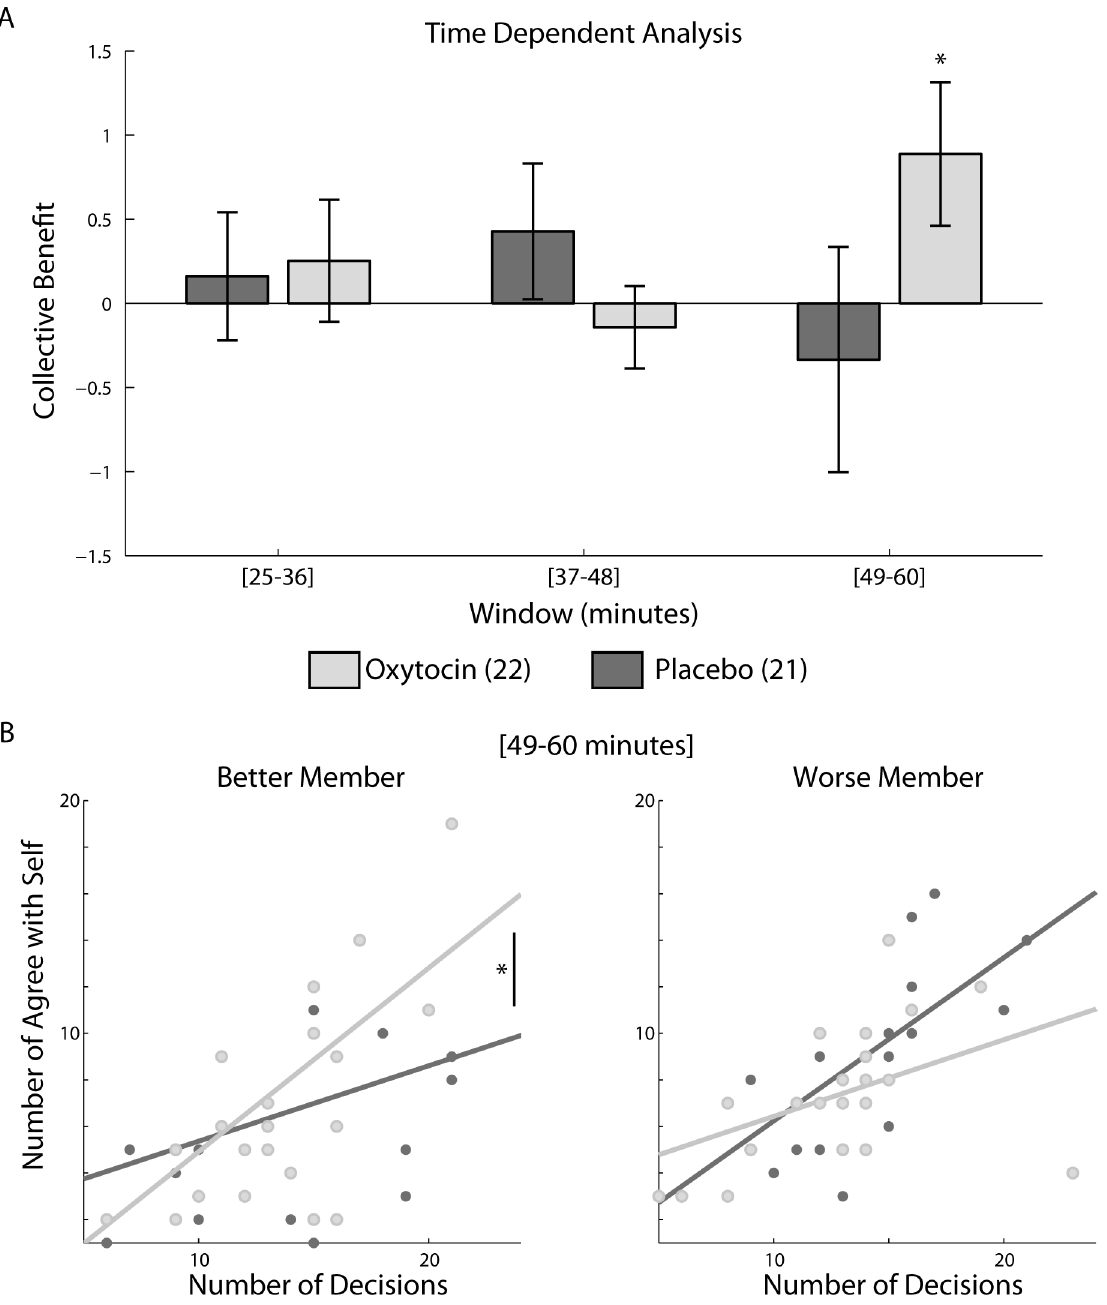
Fig 4. Time dependent analysis: overcoming equality bias under oxytocin. (A) We used an exploratory time dependent analysis of collective benefit, to examine whether oxytocin effect is dependent on time from administration. We estimated collective benefit in three 12 minutes time windows, with the last window in the expected time window for oxytocin effect (49 – 60 minutes after administration). A significant interaction effect was found (Treatment X Time F (2,82) = 3.14 p = 0.048). This interaction effect depends on the marked increase in collective benefit under oxytocin in the [49 – 60] minutes, the only time collective benefit was significantly higher than 0 (p = 0.045). (B) The relation between number of egocentric joint decisions and number of overall joint decisions made by the better dyad members (left panel), and the worse dyad members (right panel), during the peak in collective benefit under oxytocin. In this time window, 49 – 60 minutes after administration, a significant interaction is seen (p = 0.008) as better members become more egocentric (p = 0.048) and worse members become less egocentric (p = 0.1), both overcoming equality